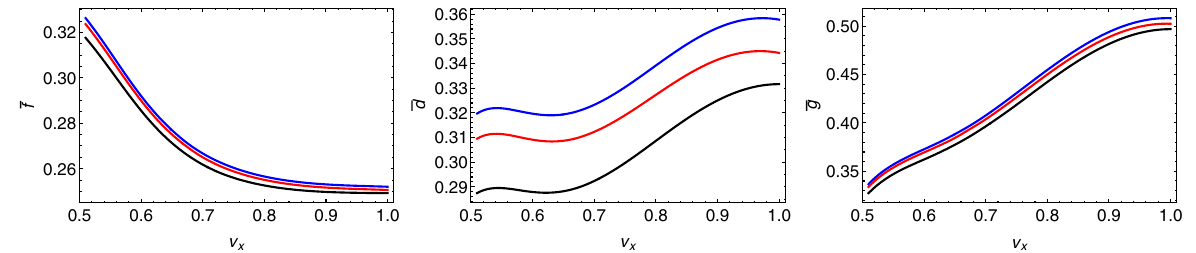
∶ ν 1 ∶ 4 ; 1 ∶ 3 , and 1 ∶ 2 y x ¼